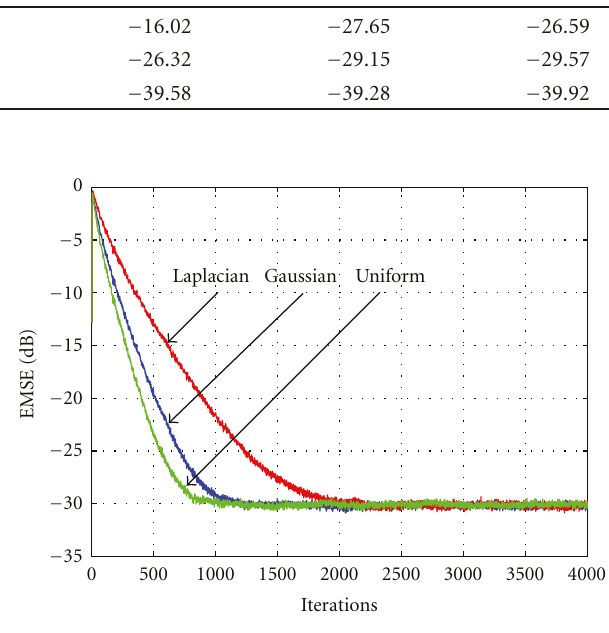
Figure 11: Learning behavior of the proposed algorithm in the di ff erent noise environments scenarios for p = 4 and α = 0 . 2.